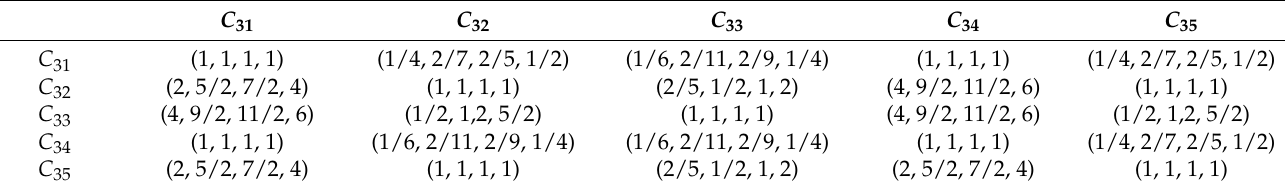
Table A4. Pair-wise comparison matrix of the sub-factor: economy ( C 3 ).